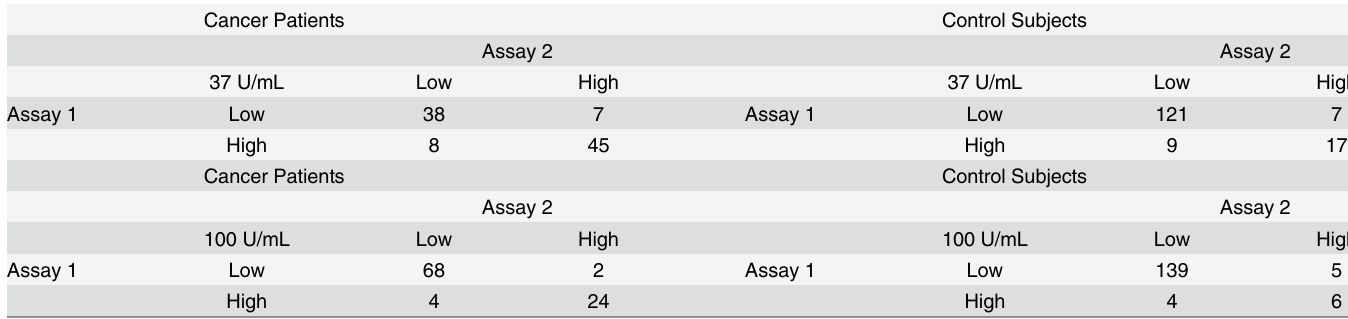
Table 3. Deviations between the assays at specific